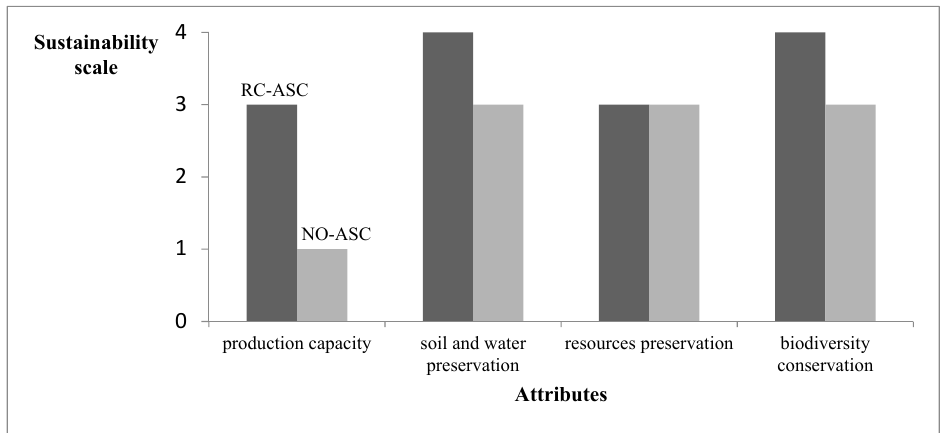
Figure 5. Production capacity, soil, and water preservation, resources preservation, and biodiversity conservation of the two different crop managements. Aggregate attributes sustainability is: 0 = low, 1 = medium low, 2 = medium 3 = medium high, 4 = high (RC-ASC = agro-ecological service crops terminated by roller crimper; NO-ASC = no agro-ecological service crops control).